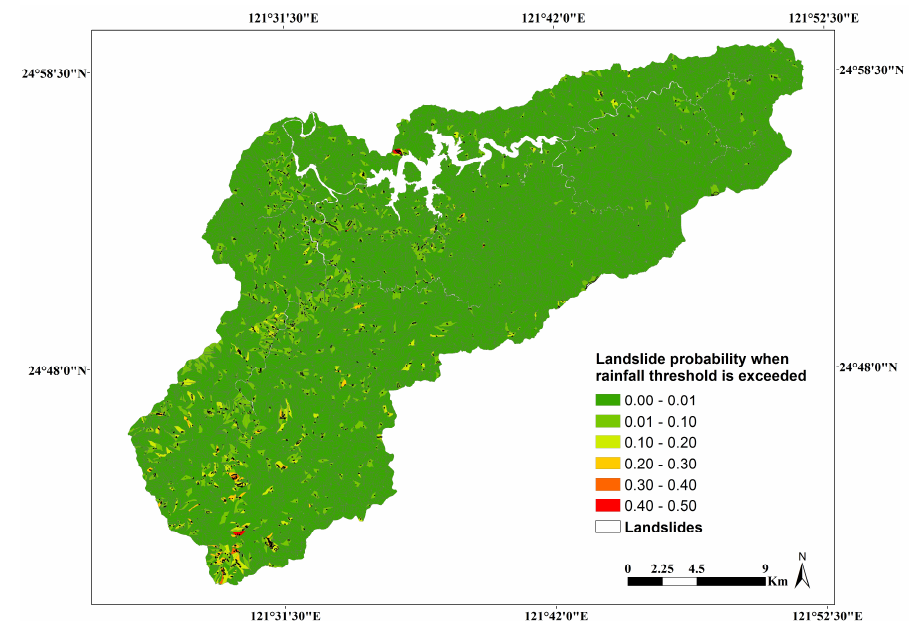
Figure 9. The landslide probability of slope units in the Taipei Water Source Domain when rainfall exceeds the threshold of discrete rainfall group.